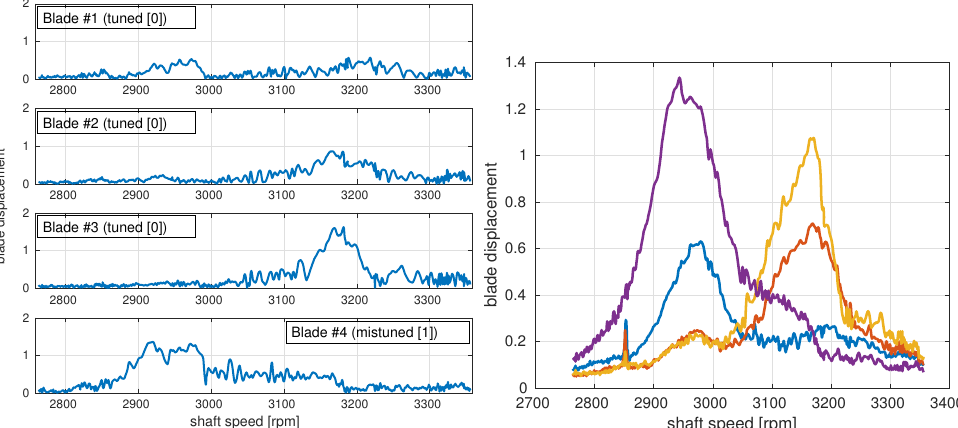
Figure 11. Experimentally measured blade displacement of the mistuning configuration [0001]. ( left ) Displacement of blades #1–4, ( right ) Averaged displacement of tuned [000] (blue, red, and yellow) and mistuned [1] (purple)